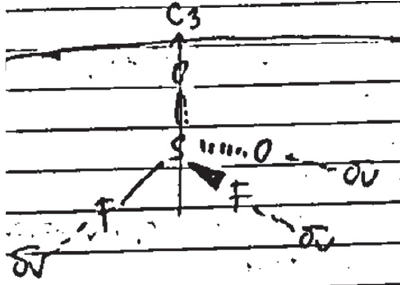
Figure 5. Example of LSA students’ error in determining the rota- tion operation of SO 2 F 2